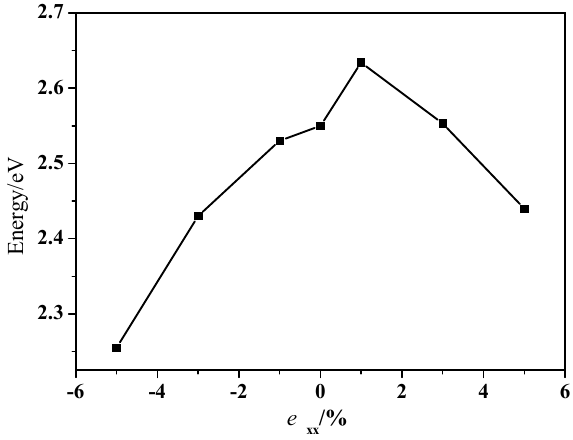
Figure 3. Energy band gaps E g of In 0.5 Al 0.5 N under different biaxial strains.